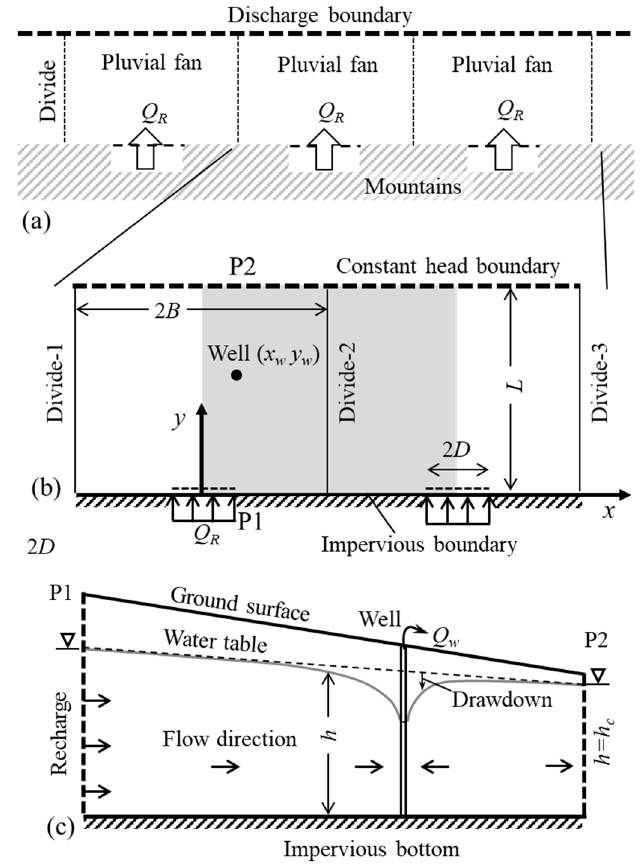
Figure 2. Conceptual model of the unconfined aquifer in a pluvial fan: ( a ) uniform distribution of pluvial fans in the plan view; ( b ) a representative area with a pumping well in the gray zone; ( c ) the profile between P1 and P2.